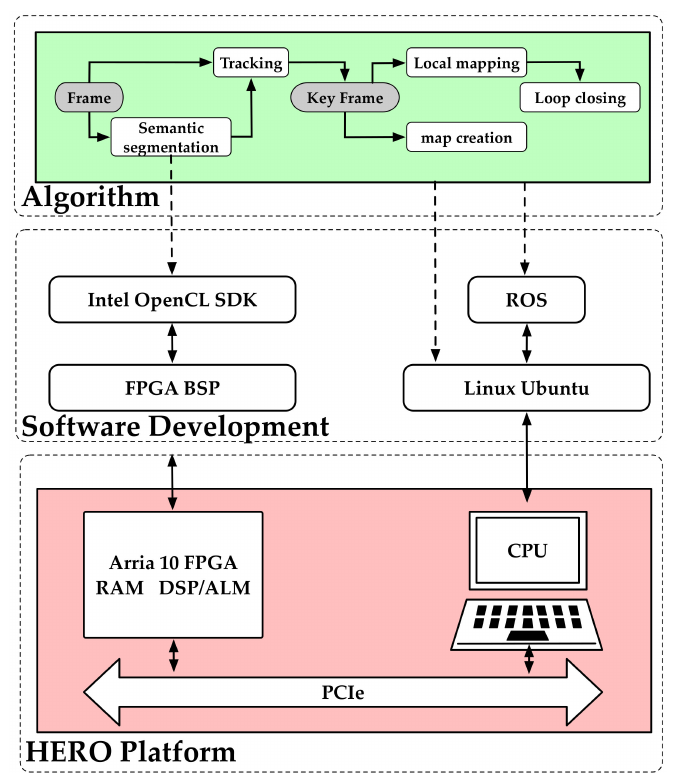
Figure 2. The DS-SLAM framework on Heterogeneous Extensible Robot Open